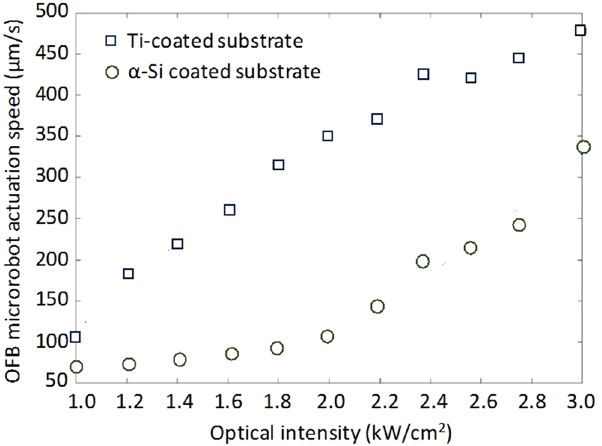
Figure 3. OFB microrobot actuation velocity on different substrates. The maximum OFB microrobot actuation speed for various intensities of the actuating laser beam is higher on substrates coated with 50 nm of titanium (Ti) as compared to substrates coated with 1 µ m of amorphous silicon ( α -Si). The size of OFB microrobots was kept constant during these